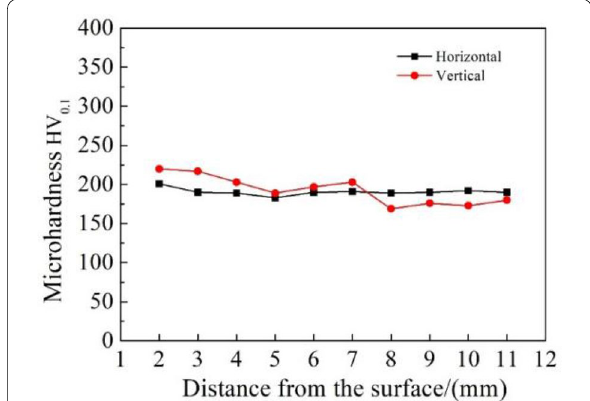
Figure 9 Microhardness distribution of the CuMn 13 Al 7 sample formed by wire arc additive manufacturing